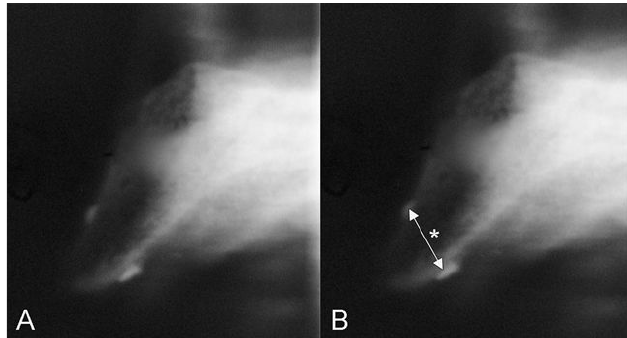
Fig.1. A . LT cross-sectional image of a marked maxillary edentulous site used to perform measurements. B. Indication of measurement (asterisk) position between the buccal and lingual markers in the same image.